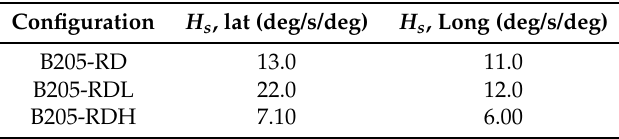
Table 4. Extracted values of H s from step inputs.